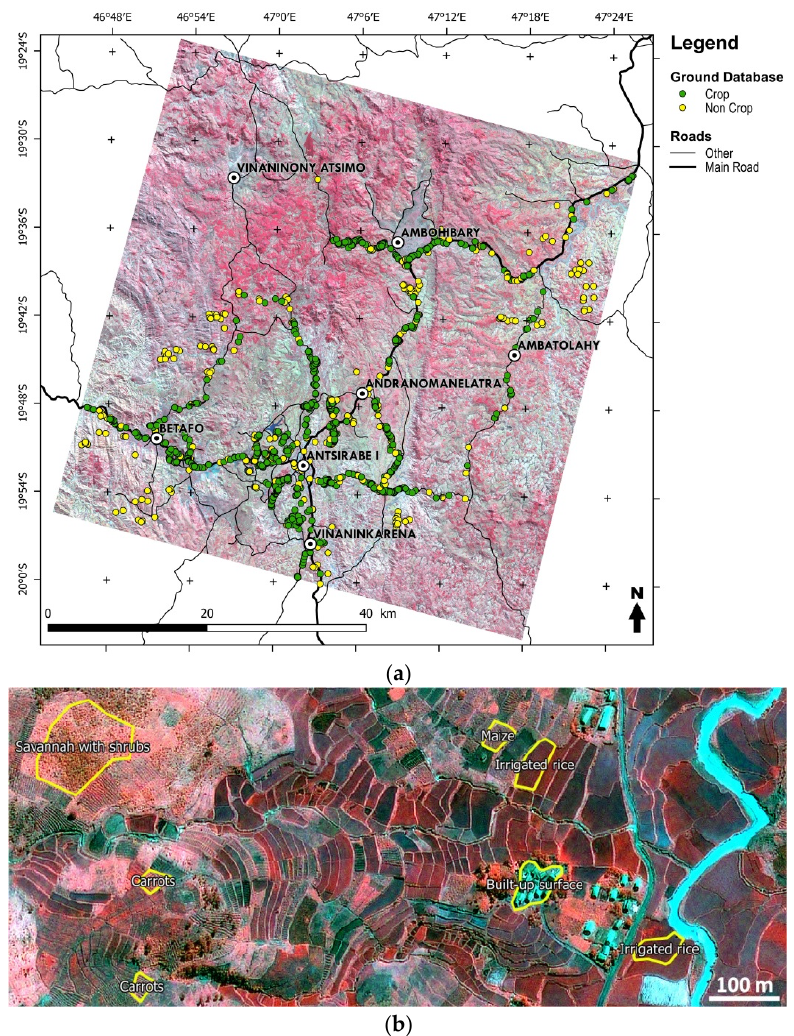
Figure 1. ( a ) location of collected waypoints in the study area (background image: Landsat 8 acquired on 15th June 2015) and ( b ) ground polygon samples (background image: PLEIADES acquired on 14th February